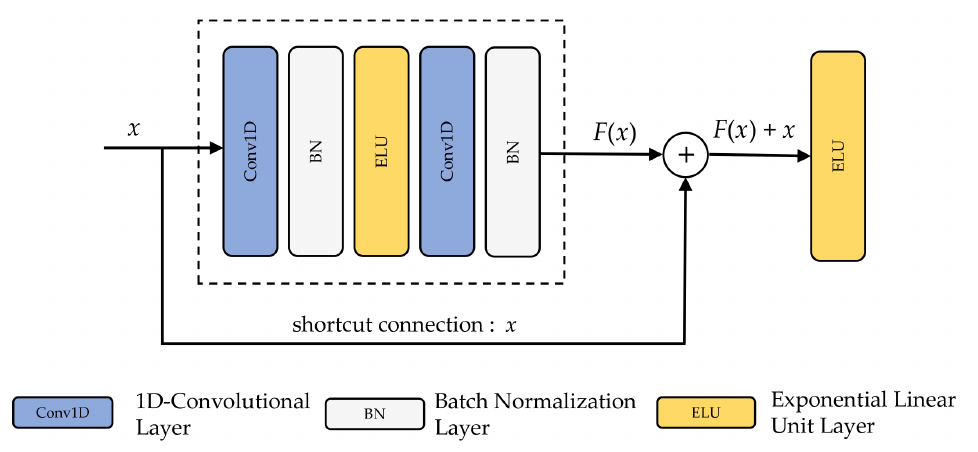
Figure 3. Structure of the residual block.